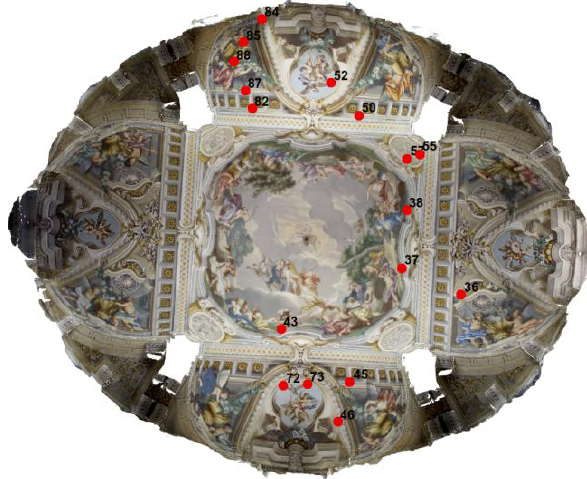
Figure 5 GCP used for bundle block adjustment